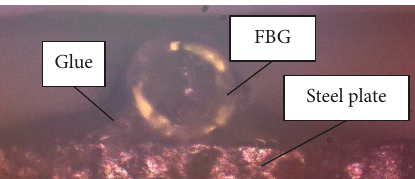
Figure 8: Electron microscopy image of the coating layer free FBG after pasting.